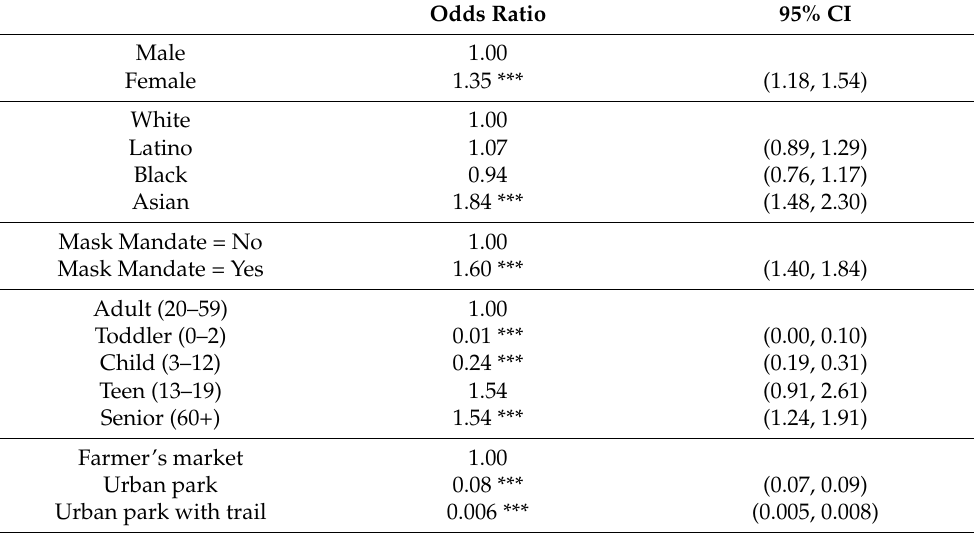
Table 3. Logistic regression estimates predicting the mask-wearing behavior in response to COVID-19, Houston, TX, January to April